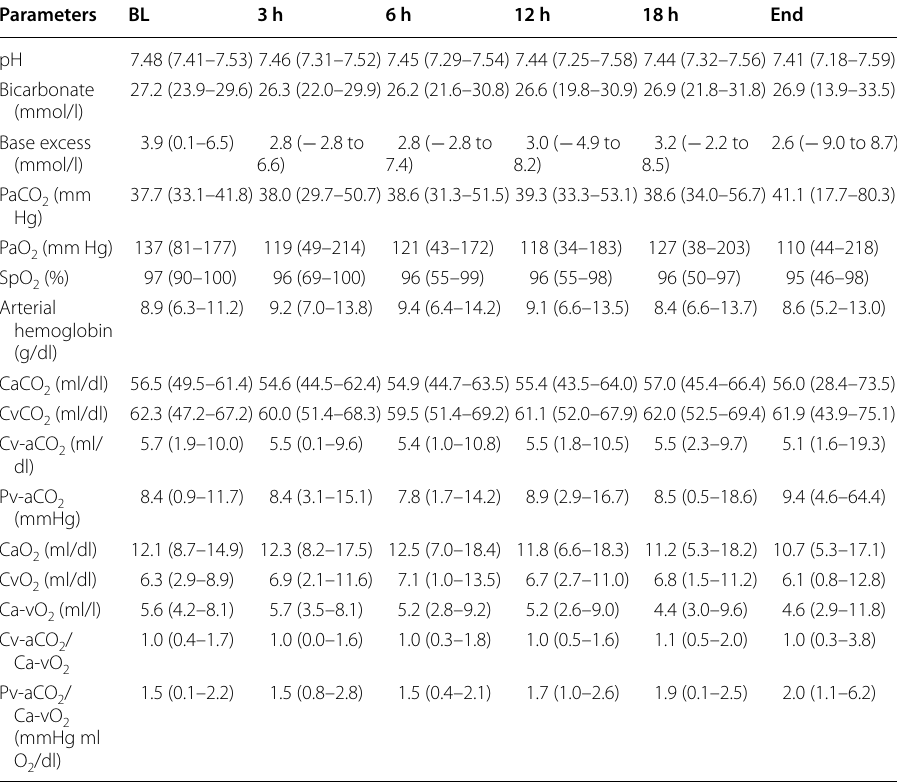
Table 2 Arterial blood gas analysis, hemoglobin and systemic carbon dioxide and oxygen